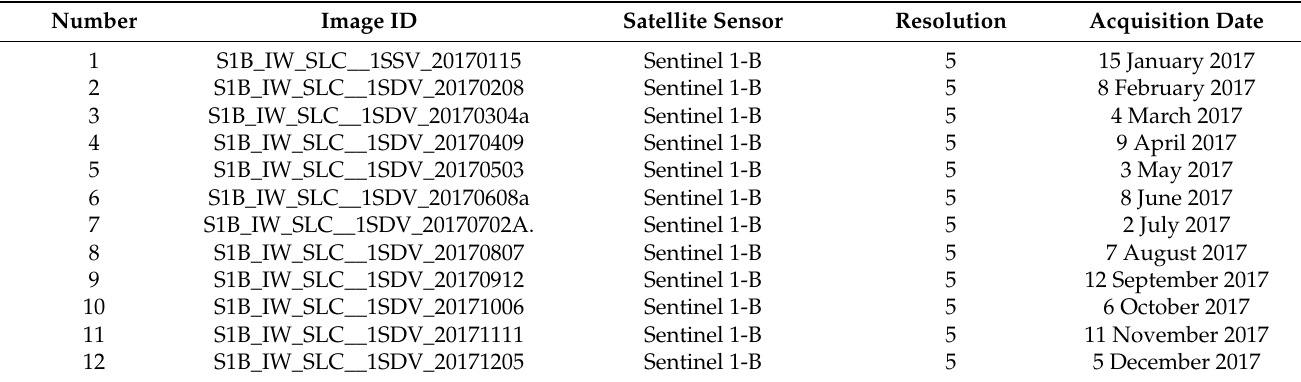
Table 2. Characterization of radar satellite images